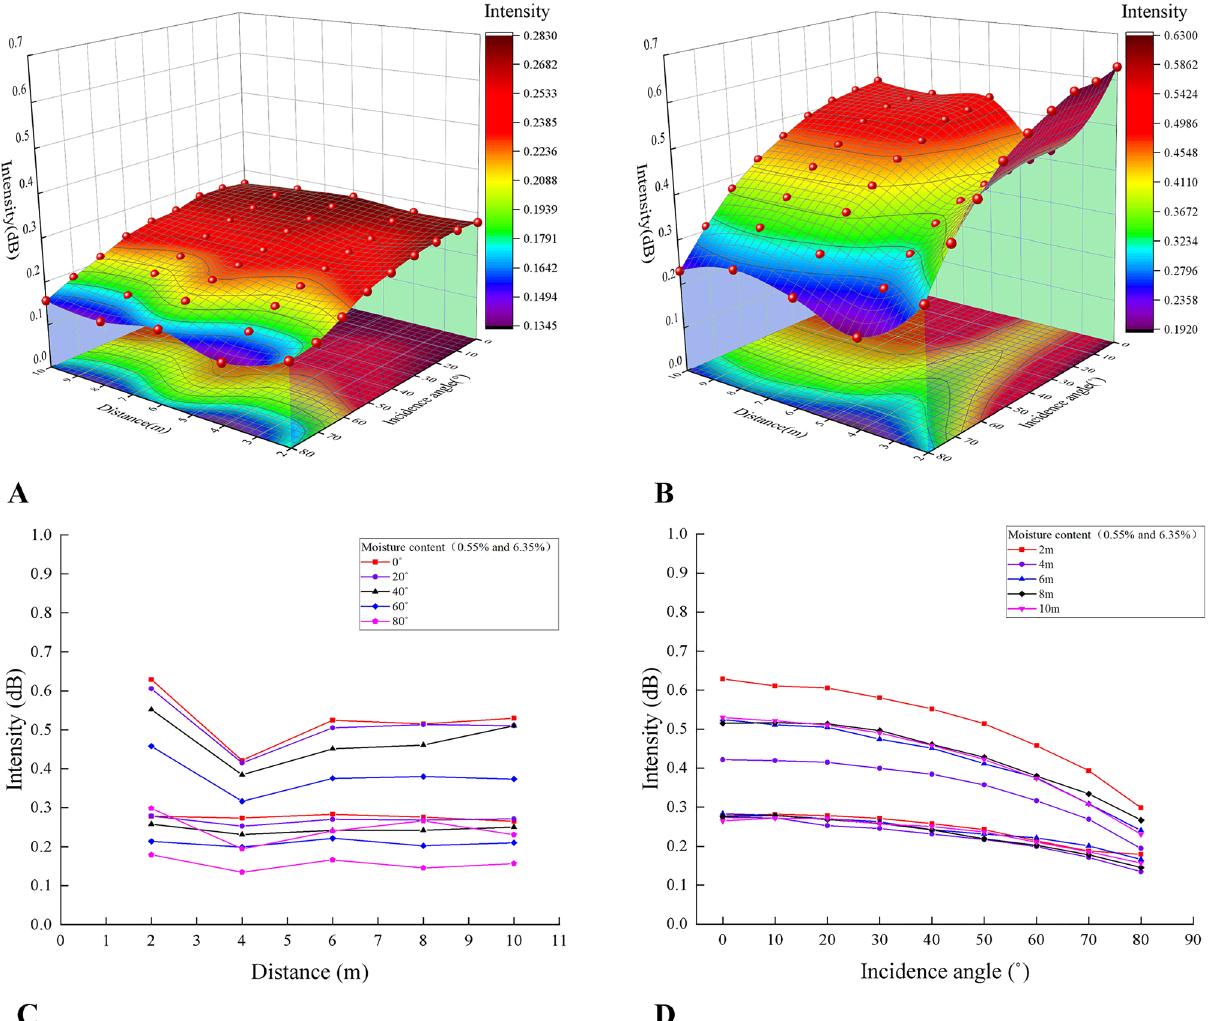
Figure 7. Composite relationships among the laser reflection intensity and incidence angle as well as distance at the moisture contents of 0.55% and 6.35% ( A , B ) and their projection relationships at the same incidence angle and distance ( C , D ) (Software: Riscan pro 2.1; riscan-pro.software.informer.com; Origin 2021b; https:// www. origi nlab. com/ index. aspx? go= PRODU CTS/